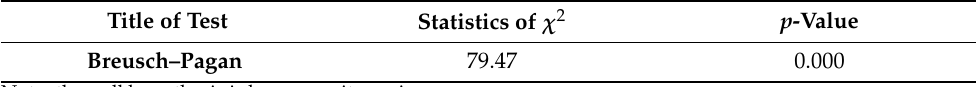
Table 12. The results of the variance heterogeneity test of the first model.